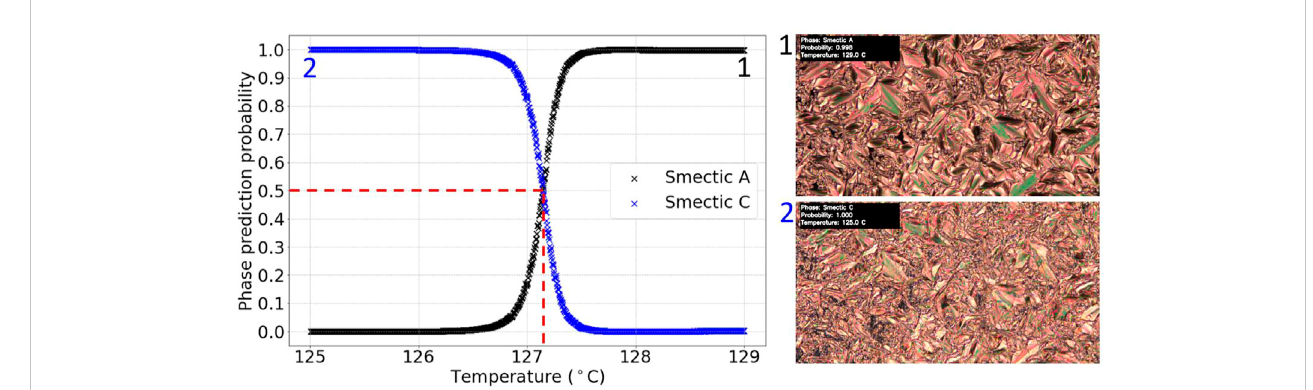
FIGURE 8 Graph of phase prediction probability against temperature for a labelled SmA*-SmC* transition test video. The vertical dashed line shows the identi fi ed transition temperature.